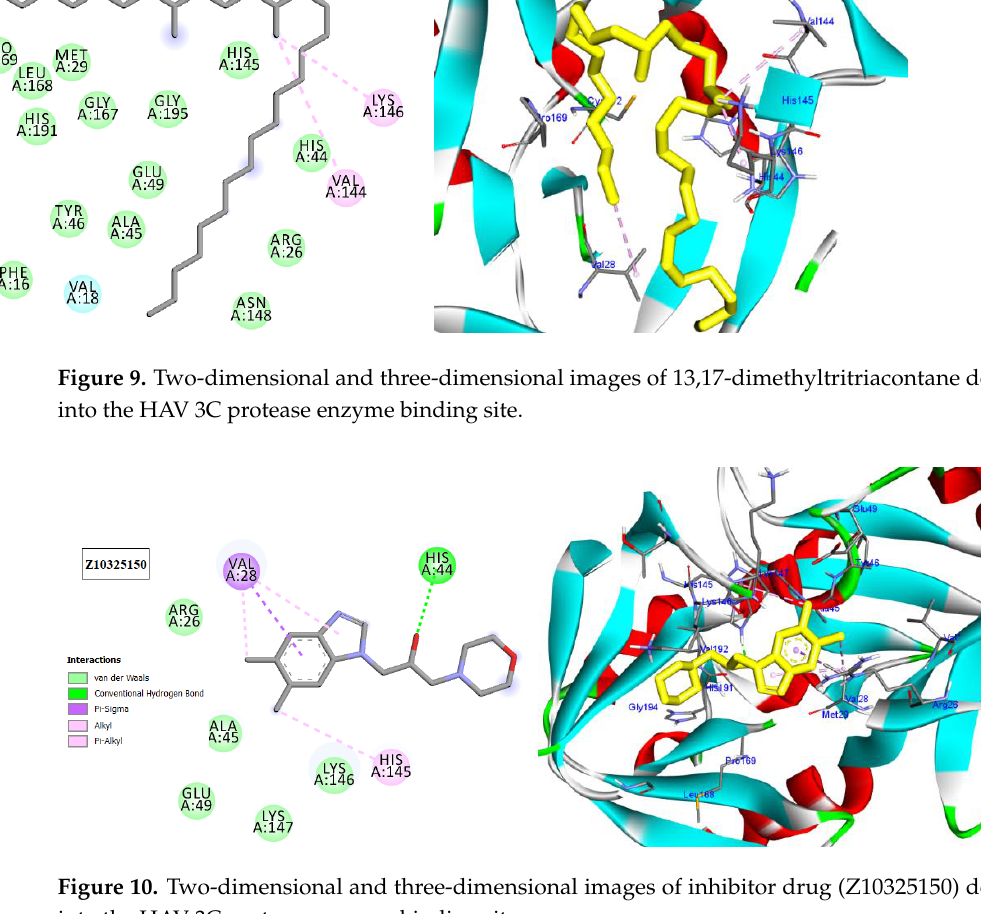
Figure 10. Two-dimensional and three-dimensional images of inhibitor drug (Z10325150) docked into the HAV 3C protease enzyme binding site.